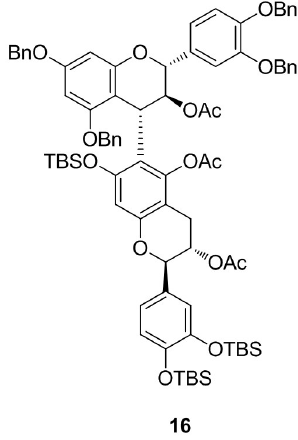
Figure 2. Acetylation derivative 16 .